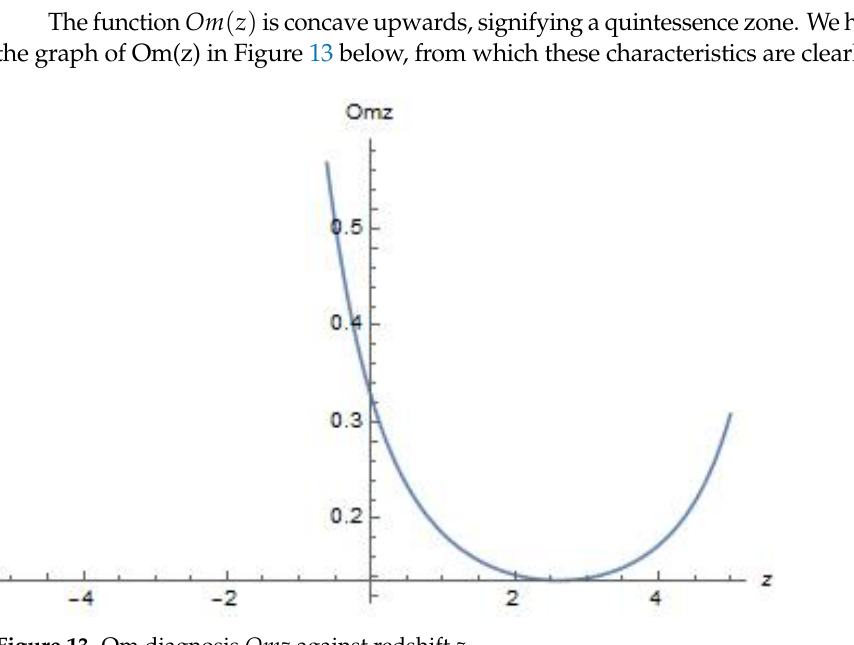
Figure 13. Om diagnosis Omz against redshift z